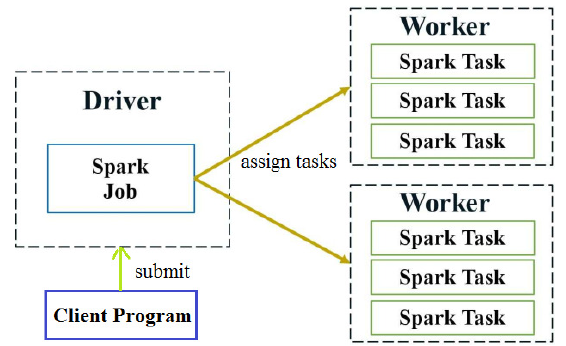
Figure 4. Distributed computing model with